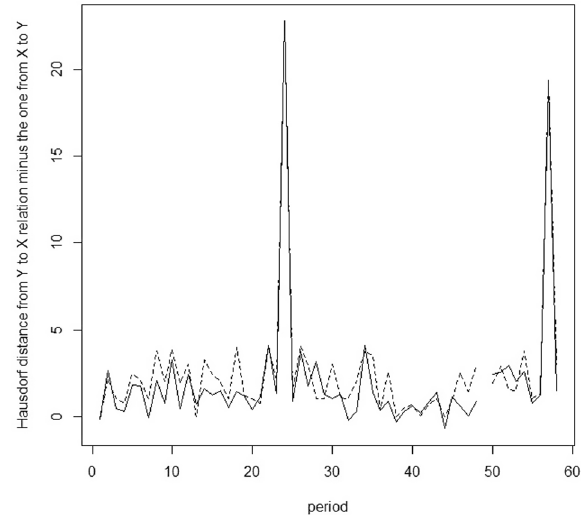
Fig. 5 Hausdorff average distance and Hausdorff minimal distance for relations. The solid line depcits the Hausdorff average distance for relations from MSP (or Y) to MHP (or X), while the dashed line depcits the Hausdorf minimal distance for relations from MSP (or Y) to MHP (or